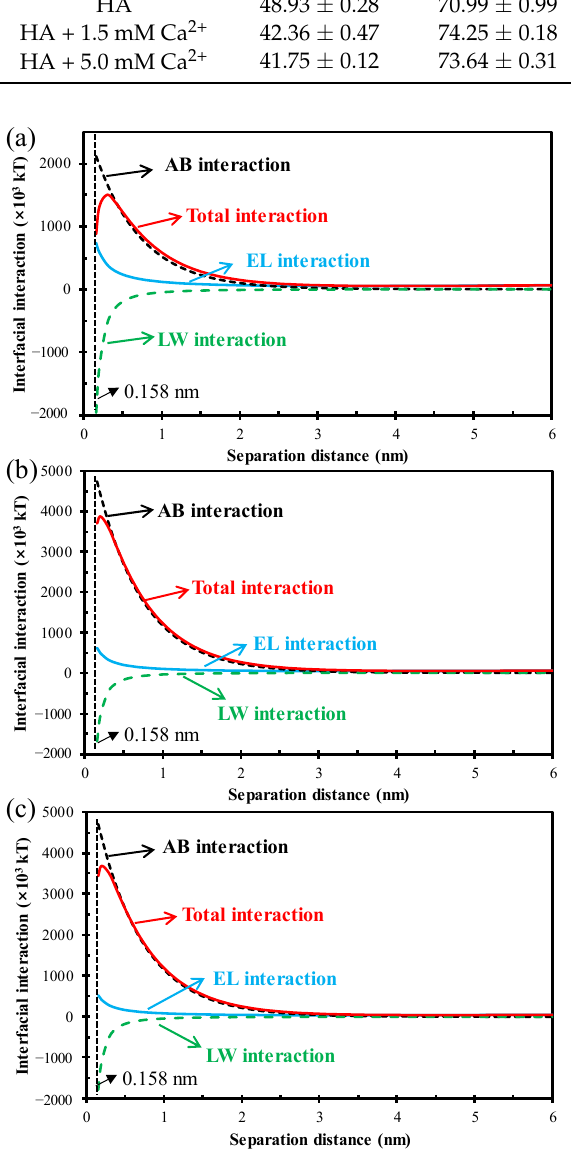
Figure 7. Profiles of interfacial interaction energies between PVDF membrane and HA with different Ca 2+ concentrations ( a ) 0 mM, ( b ) 1.5 mM, and ( c ) 5.0 mM.